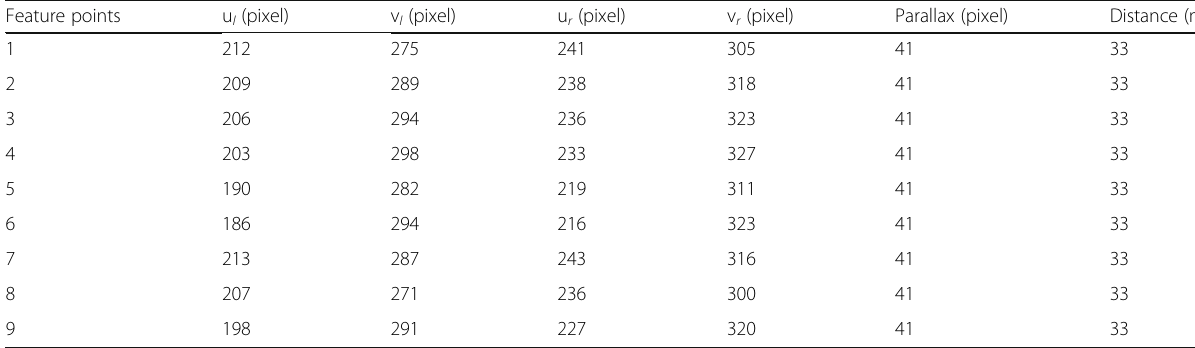
Table 1 Information of left and right view feature points Feature